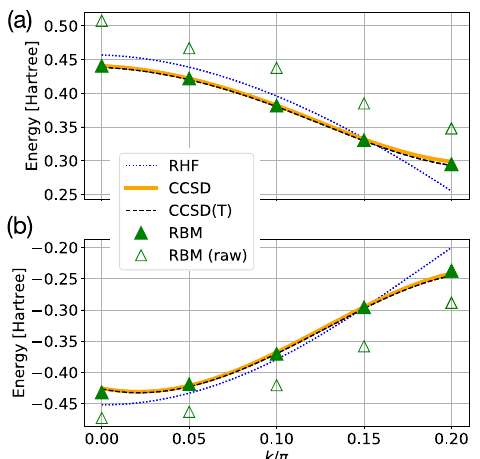
Fig. 5 The effect of energy correction to quasiparticle bands. Here, we display the a lowest conduction band and b highest valence band. The un fi lled green triangle denotes the raw values obtained by solving Eq. (6) de fi ned in the main text, and the fi lled ones indicate the values corrected by Eq. (9) following the extended Koopmans' theorem. The blue dotted lines, yellow lines, and black dashd lines indicate the result by restricted Hartree – Fock method, coupled-cluster equation-of-motion formalism with singles and doubles (EOM-CCSD), and EOM-CCSD with perturbative triple excitation (EOM-CCSD(T)(a)*),